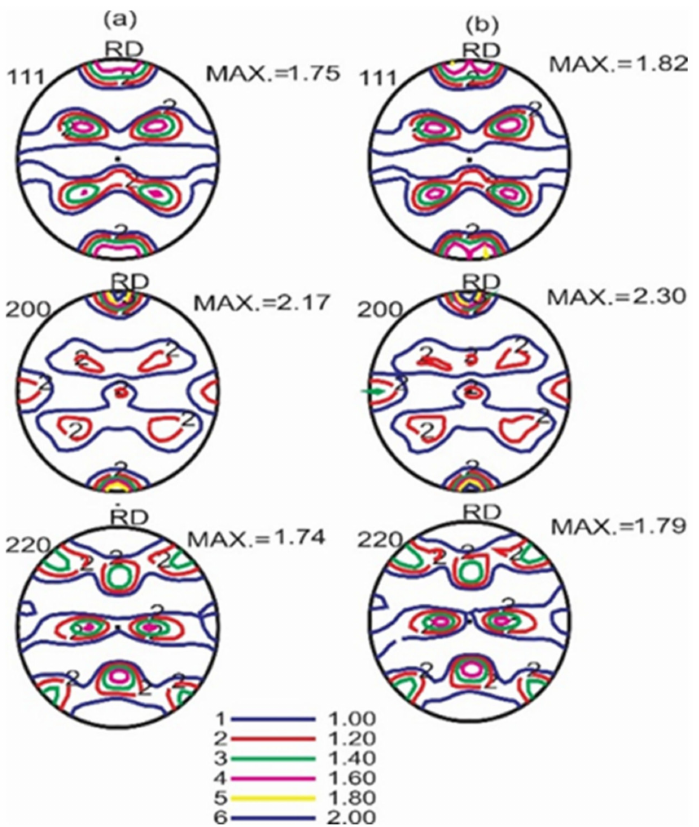
Figure 4. {111}, {200}, and {220} PFs of the as-received tubes at ( a ) max and ( b ) min positions, reprinted with permission from [18]. 2019,